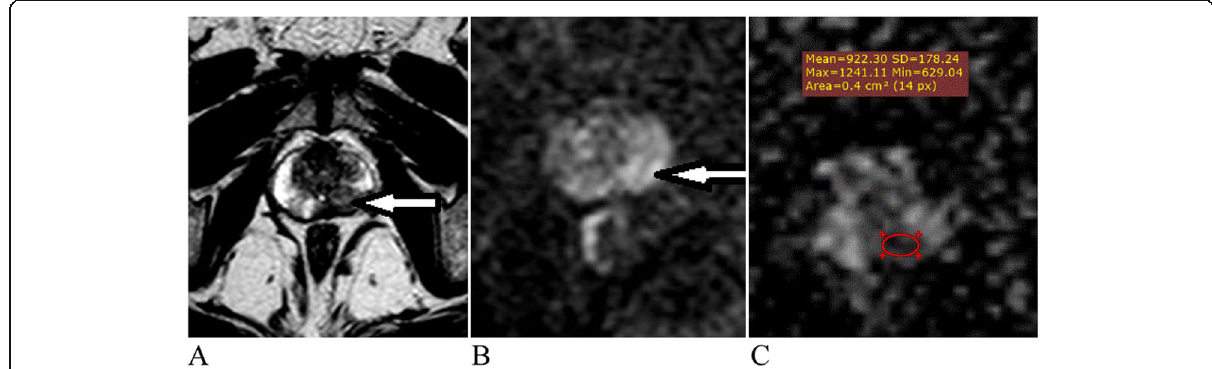
Fig. 1 A 67-year-old man with PSA 16 with discordant interpretation in terms of PIRADSv2 DWI score. a Axial T2 showing a moderately hypointense lesion located dorsally in the left peripheral zone of the apex not abutting the capsule. b DWI of b 800 shows a focal area of moderate hyperintensity, measuring 1.1 cm, in left PZ (arrow). CADC map also shows low signal intensity of the lesion with mean ADC value 0.922. The ADC ratio was 1.33. The qualitative DWI score was 4 for reader 1 and 3 for reader 2. Histopathology was Adenocarcinoma GS 3 + 3 = 6; tumor volume = 1.1 cm 3 ; organ-confined)